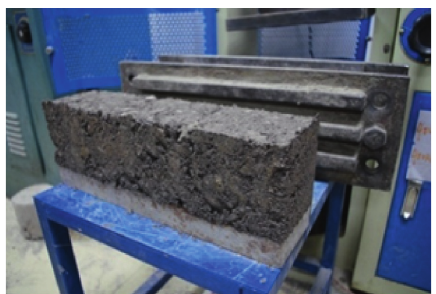
Figure 6: Isostatic pressure forming.